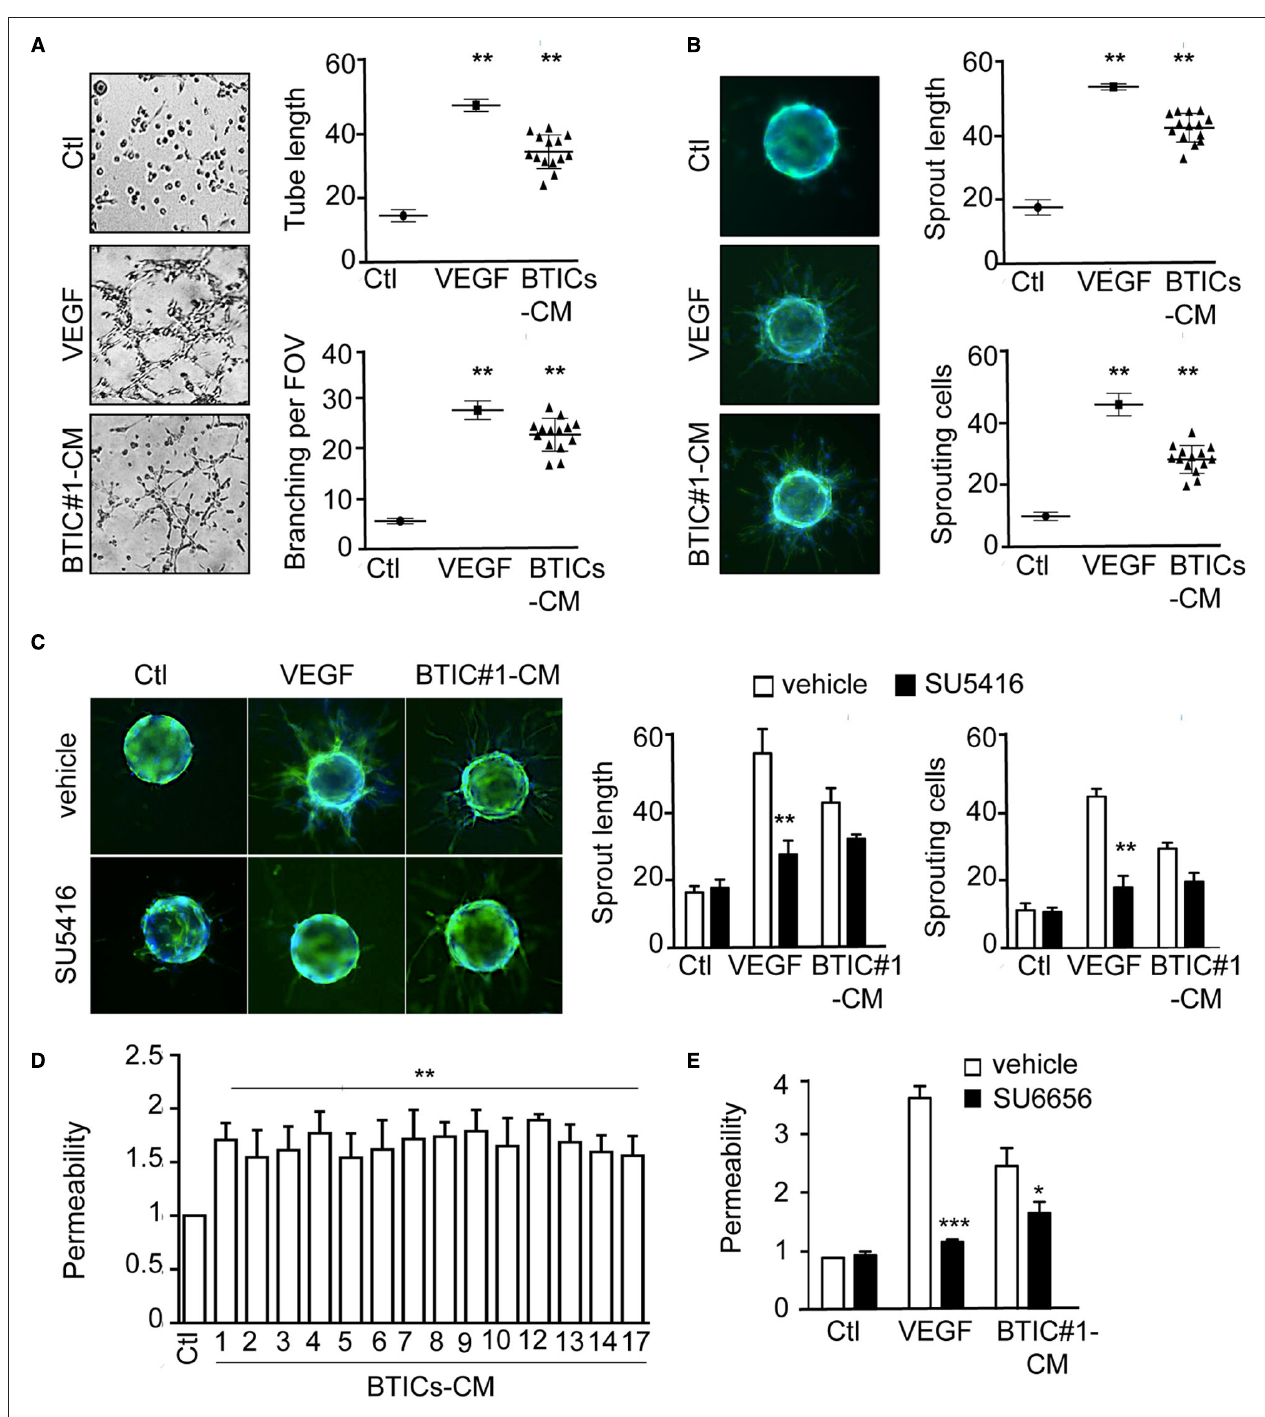
FIGURE 1 | Patient-derived BTICs-secreted factors induced brain endothelial cell remodeling, independently of the VEGF-R2/Src axis. (A) Brain endothelial hCMEC/D3 cells were tested for tube formation capacity in response to VEGF and all 14 BTICs-derived conditioned media. Representative images are shown. Tube length and number of branch points per field of view (FOV) were quantified. (B,C) hCMEC/D3 cells sprouting ability was evaluated in the absence (B) or presence (C) of the VEGF R2 inhibitor SU5416 (5 m M). The number of sprouting cells and mean sprout length were determined. (D,E) Permeability of brain endothelial cells treated with BTICs-derived conditioned media. Cells were pre-treated with DMSO (Vehicle) or SU6656 (Src inhibitor, 1 m M) prior BTICs-CM treatments in (E) . Data are expressed as fold change relative to the control. *** p < 0.001, ** p < 0.01, * p < 0.05 by analysis of variance (ANOVA). Each panel is representative of at least three independent